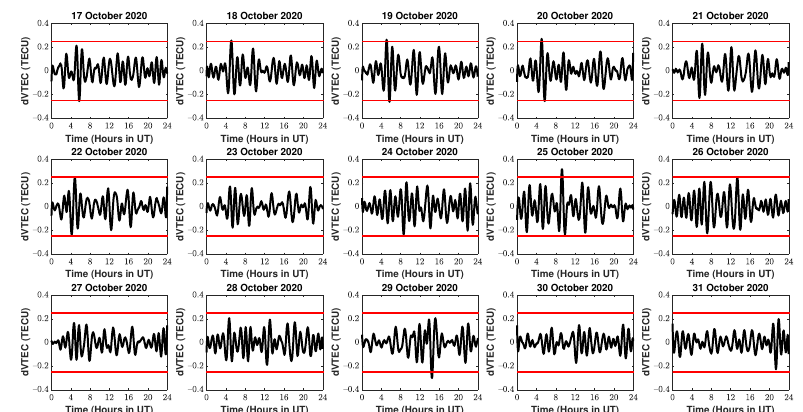
Figure 10. Same as Figure 7, but for IZMI station.